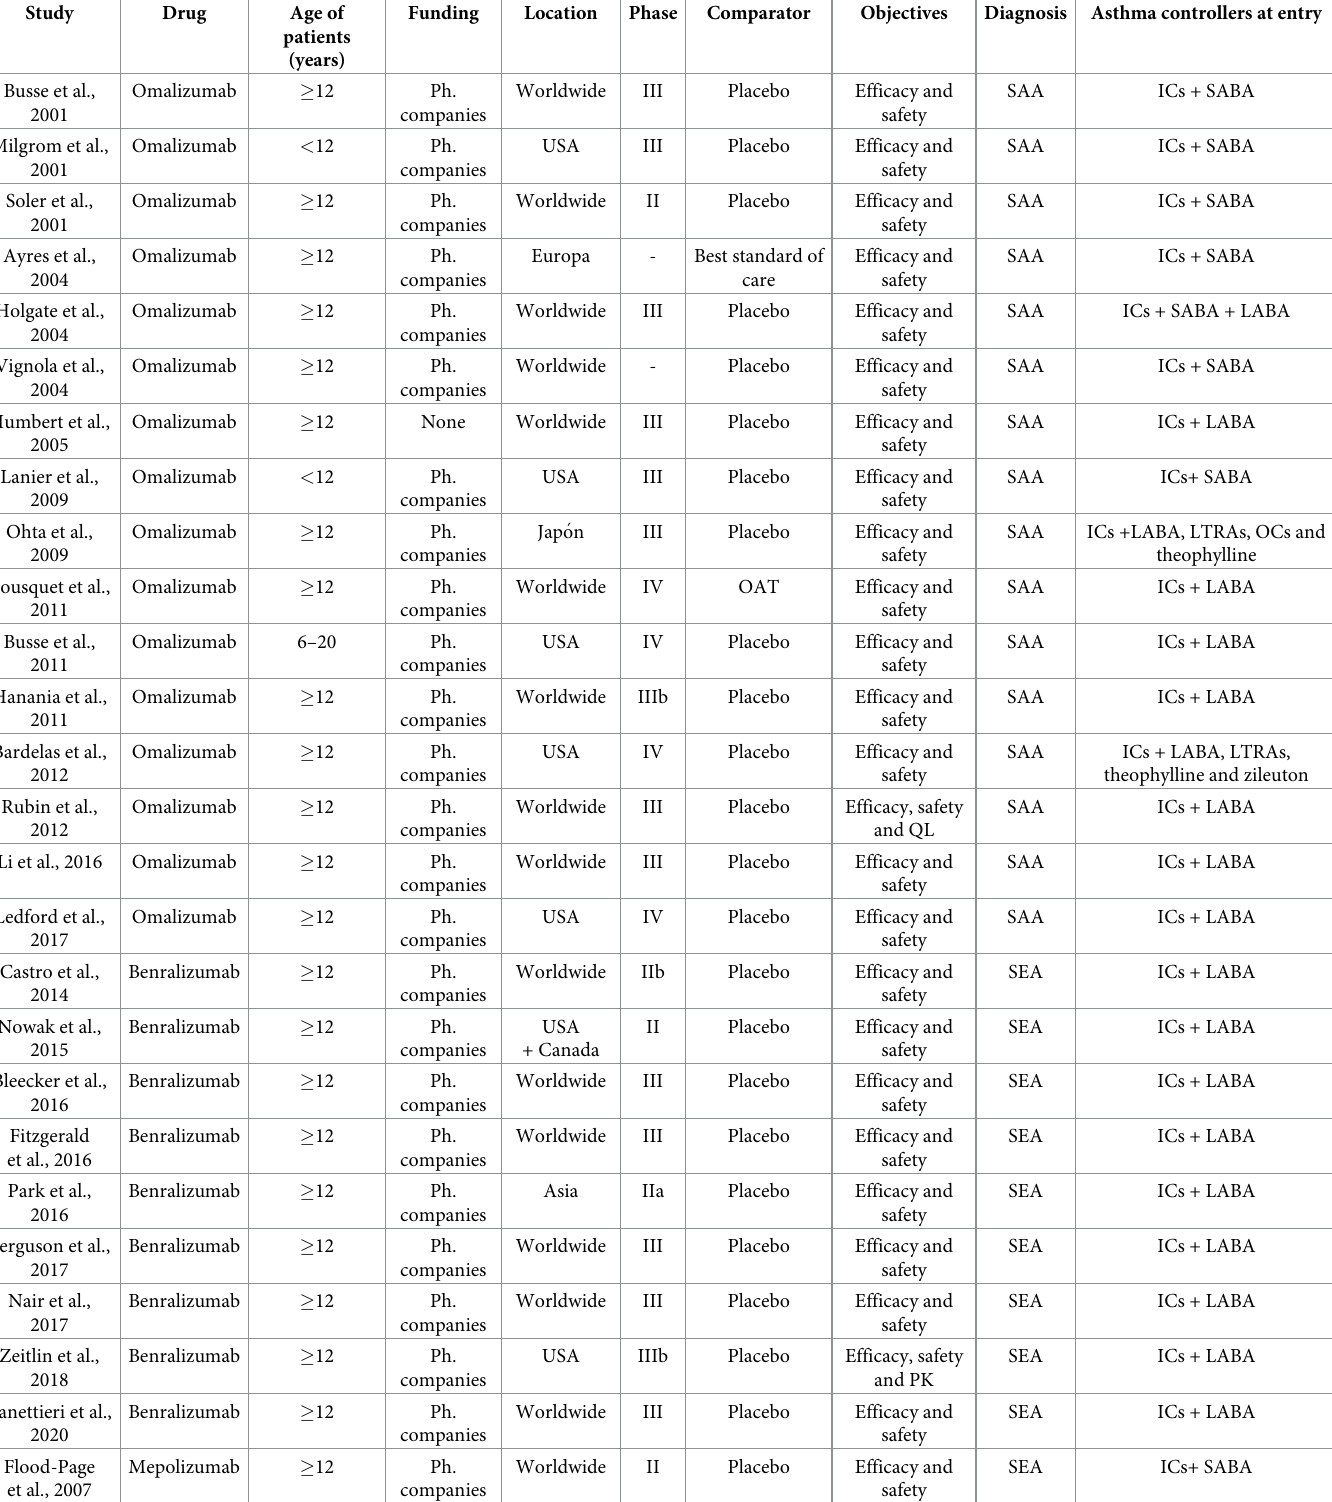
Table 2. Characteristics of CTs